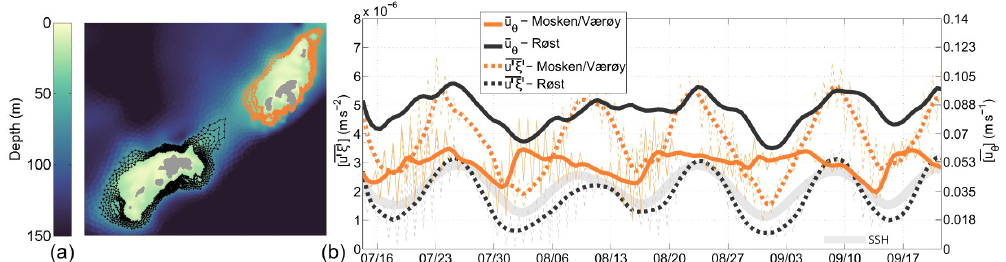
Figure 14. Reynolds vorticity flux and tangential flow calculated around closed depth-contours encircling Røst (black curves) and around Mosken–Værøy (orange curves), shown in panel (a) . Panel (b) shows time series the mean Reynolds vorticity flux ( u (cid:48) ξ (cid:48) · ˆ n , dashed lines) out of closed depth contours that wrap around Mosken–Værøy (orange) and around Røst (black), and azimuthal velocity ( ¯ u θ = ¯ u · ˆ t , solid lines), both averaged around the same closed contours. All quantities shown by thick lines have been smoothed over four M2 cycles and also averaged over a set of closed contours between 30 and 70m. The thin curves with brighter colors in the background are velocities averaged over one M2 tidal cycle. Sea surface height fluctuations (thick gray line) over southern Lofoten are also